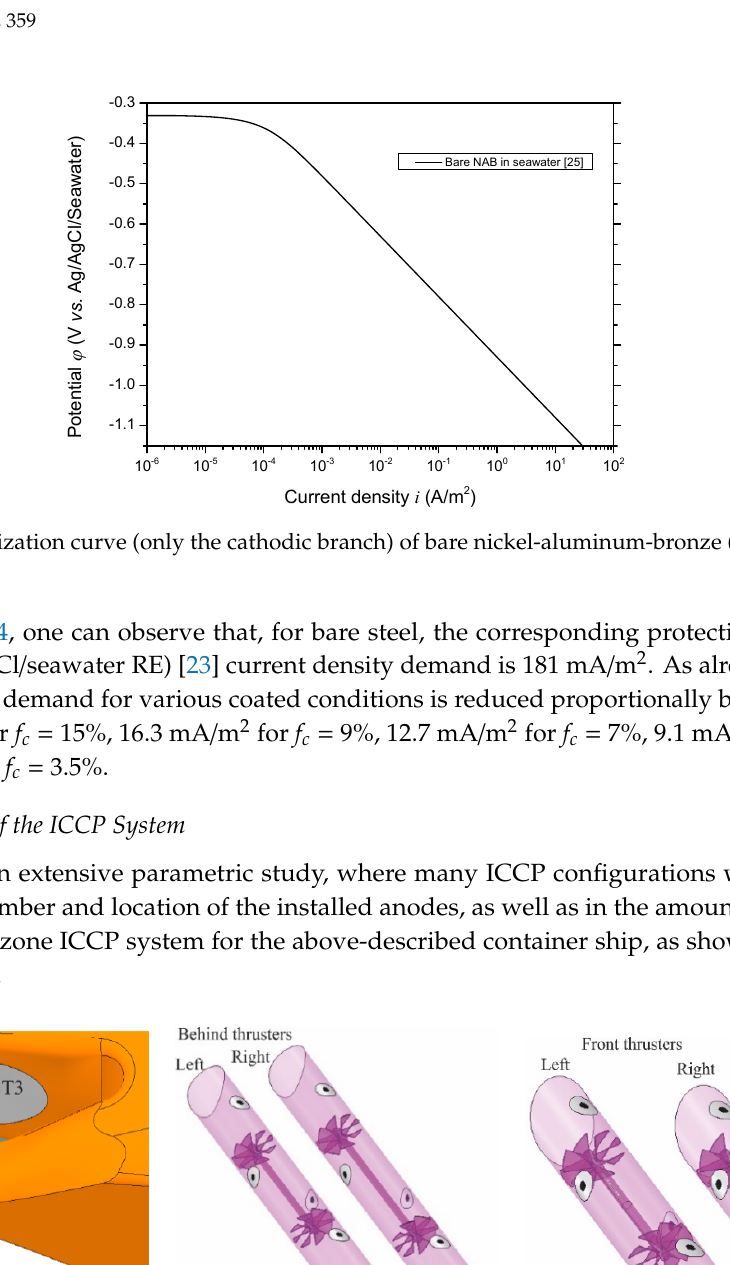
Figure 5. Polarization curve (only the cathodic branch) of bare nickel-aluminum-bronze (NAB) alloy in seawater.